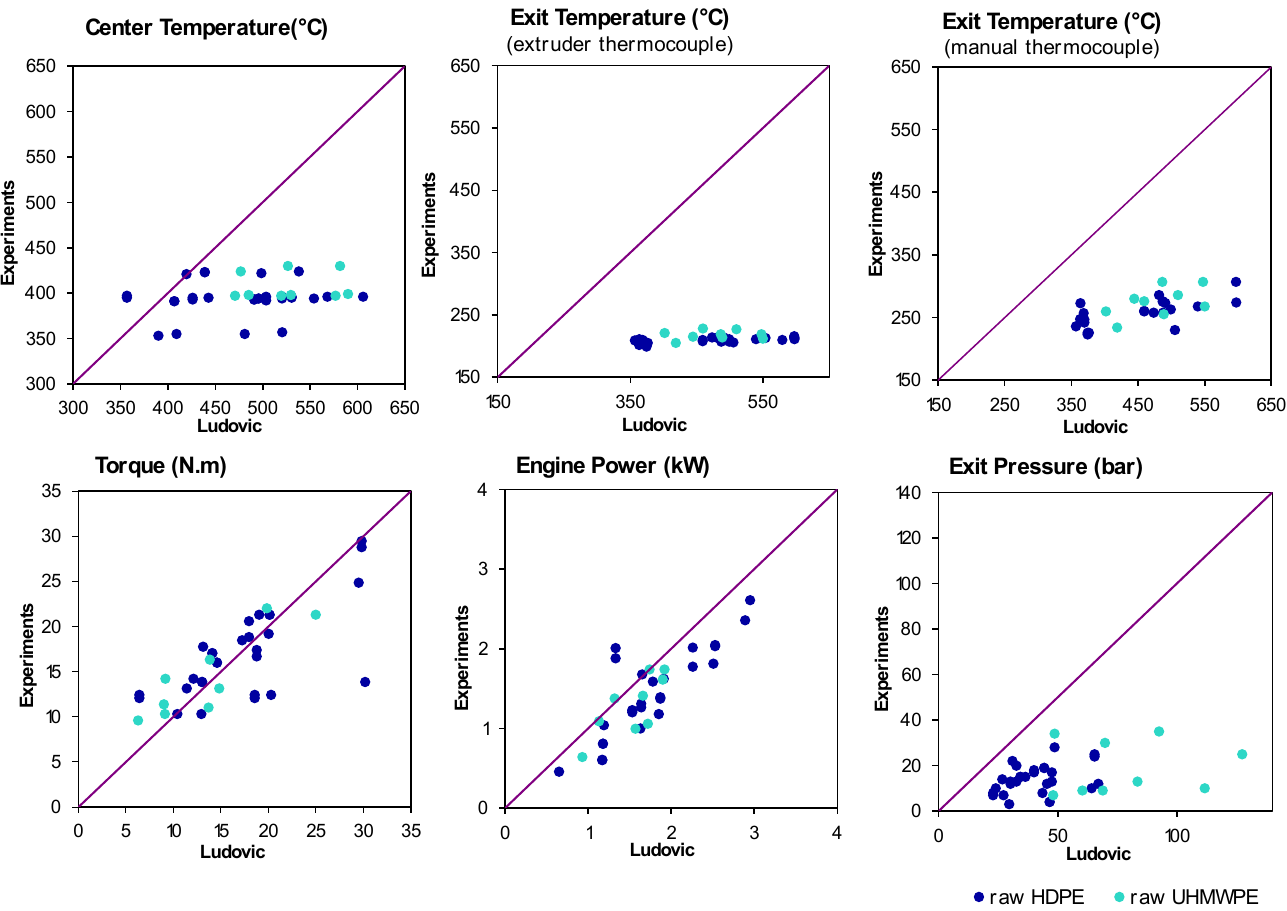
Figure 9. Comparison of Ludovic ® Simulation versus Experimental data for in-line measured pa- rameters.